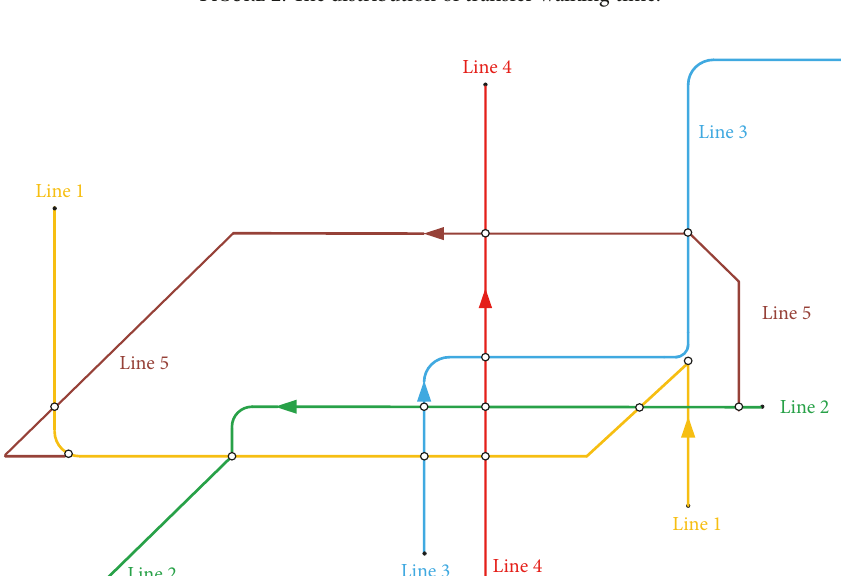
Figure 3: Network topology of Shenzhen